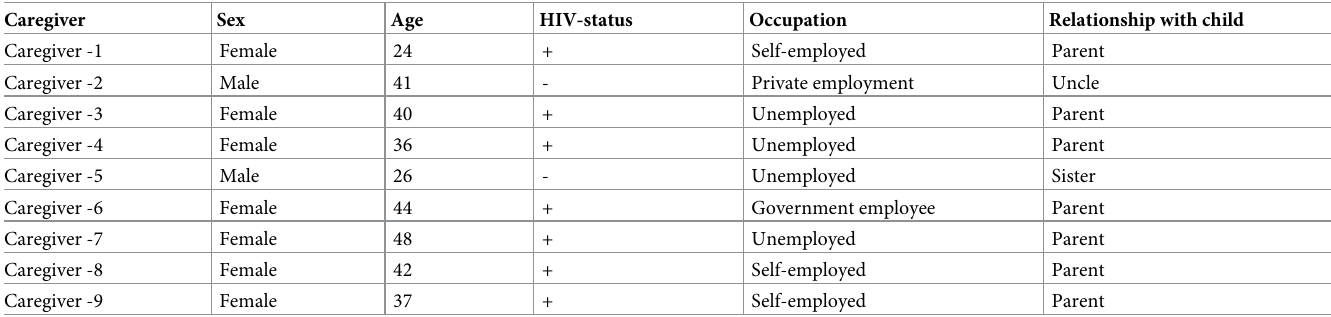
Table 1. Participant